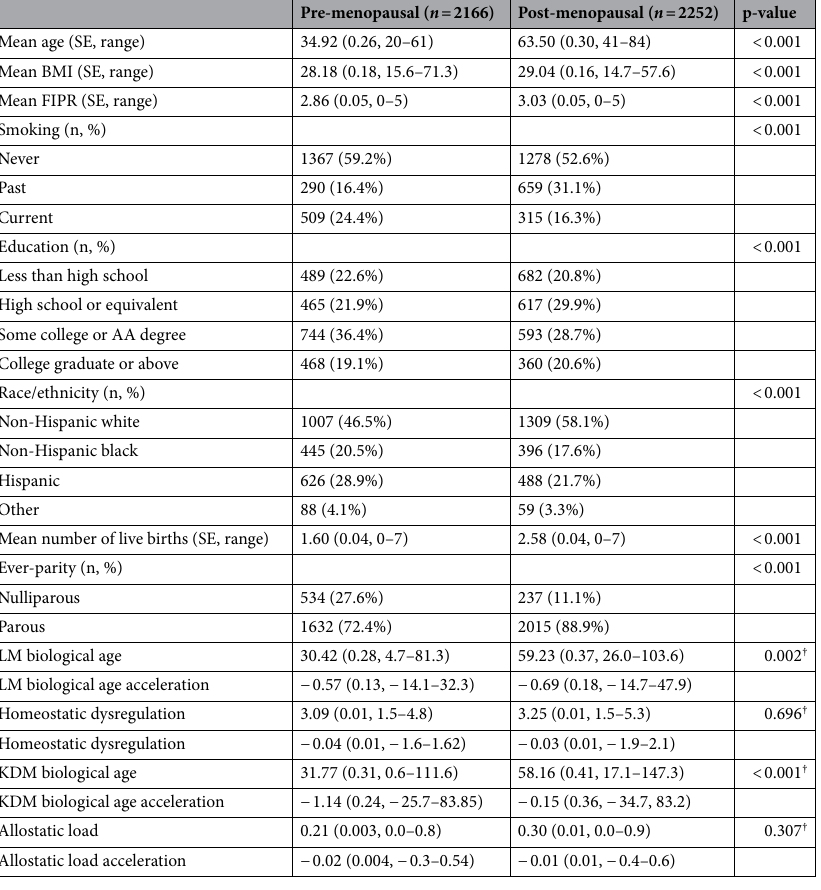
Table 1. Sample demographic characteristics ( n = 4418), National Health and Nutrition Examination Survey, 1999–2010. Means, standard errors (SE), and percentages represent nationally-representative estimates based on adjustment for complex survey design, survey nonresponse, non-coverage, and complex survey design. Unless otherwise noted, p-values reflect tests of difference via t test or Chi-Square as appropriate. † p− values from linear regression models adjusted for the following variables: chronological age, body mass index, federal income-to-poverty ratio, smoking, education, and self-identified race/ethnicity.